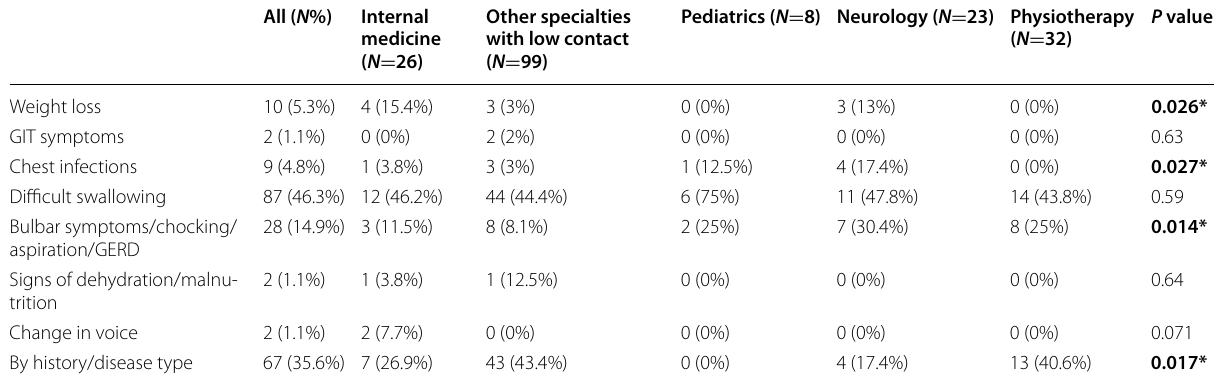
Table 1 Comparison among the participants in different specialties regarding their responses about dysphagia symptoms, signs, and